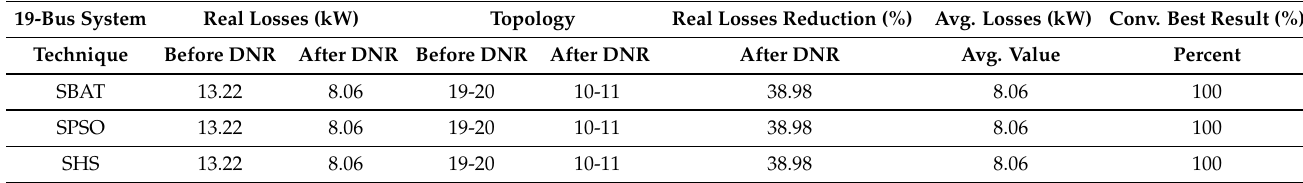
Figure 8. 69-bus and 73-branch system final configuration. Table 8. Results found for the 19-bus and 20-branch unbalanced system (fixed demand).